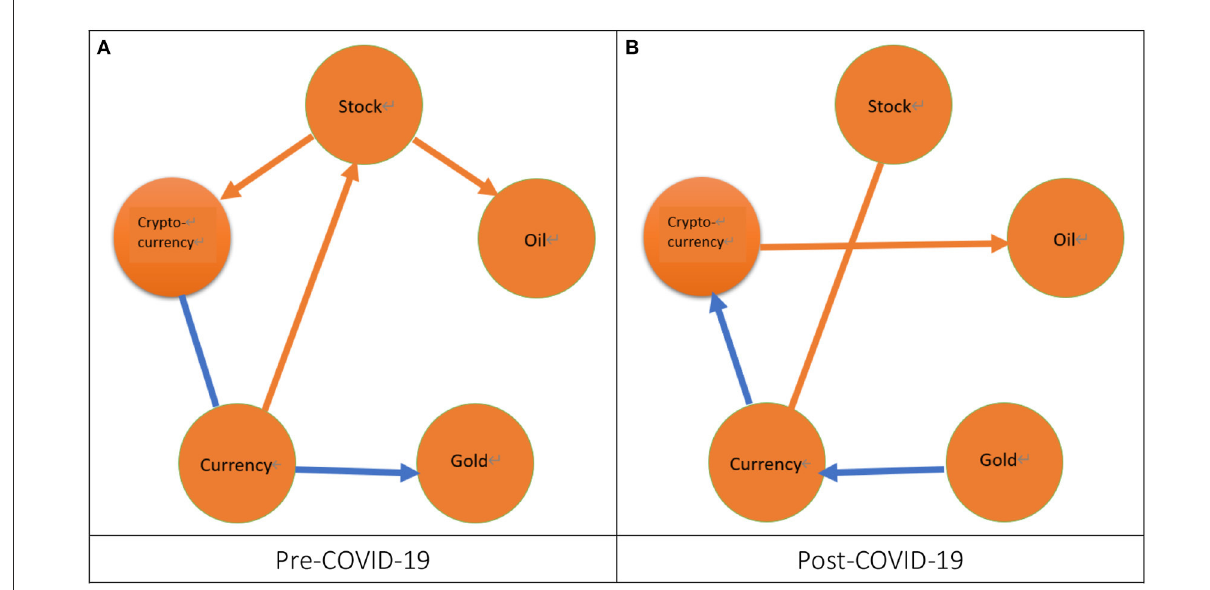
FIGURE2 The network of return spillover. 1. The orange arrow from a specific node to another node denotes a significant return spillover from a market represented by this specific node to another market represented by another node. 2. The blue arrow from a specific node to another node represents a slightly significant return spillover from a market represented by this specific node to another market represented by another node. 3. The orange line connected by two nodes denotes a significant return spillover between two markets represented by these two nodes but the direction of this spillover is uncertain. 4. The blue line connected by two nodes denotes a slightly significant return spillover between two markets represented by these two nodes but the direction of this spillover is uncertain. (A) Pre-COVID-19 and (B)